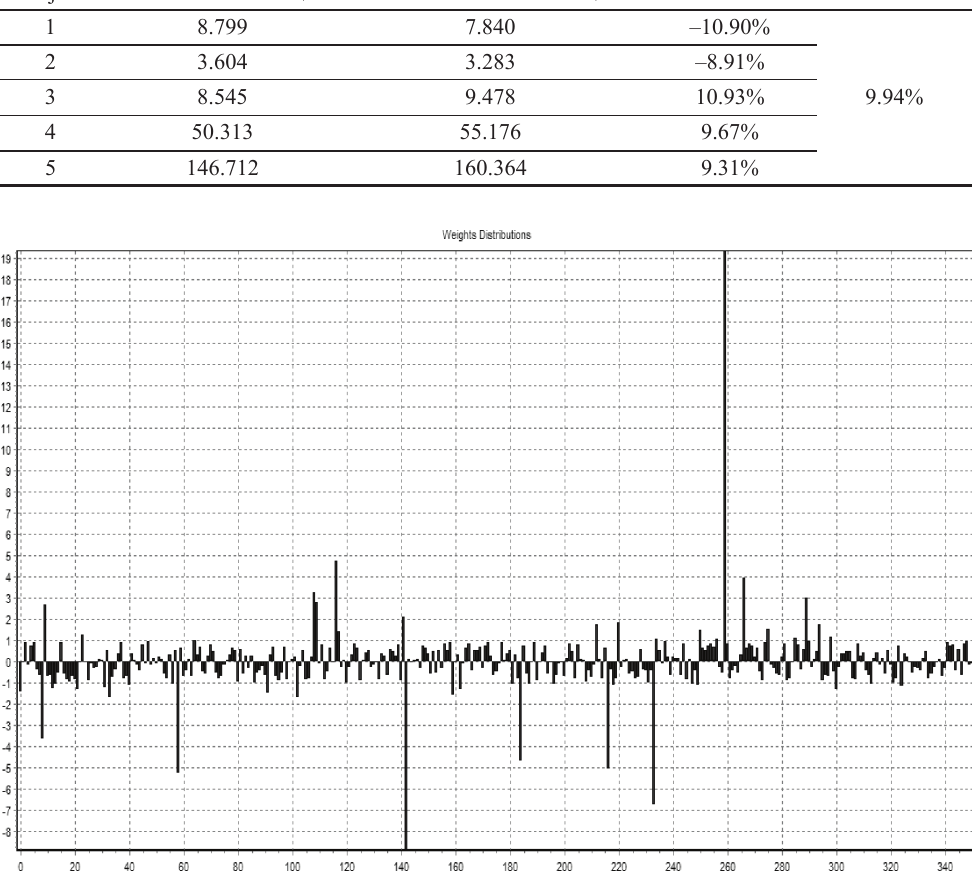
Fig. 3. Weight distribution of neural network Model-3 (M3)